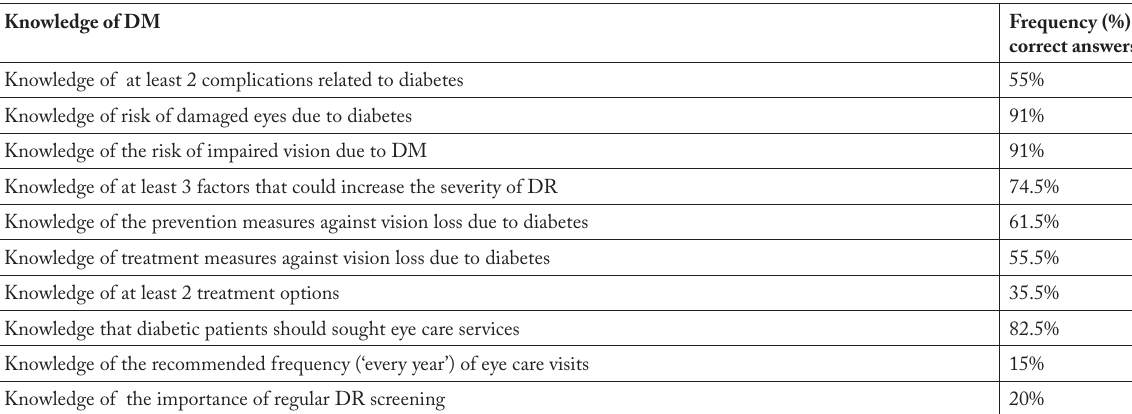
Table 2. Summary of correct response on knowledge questions (participants n =